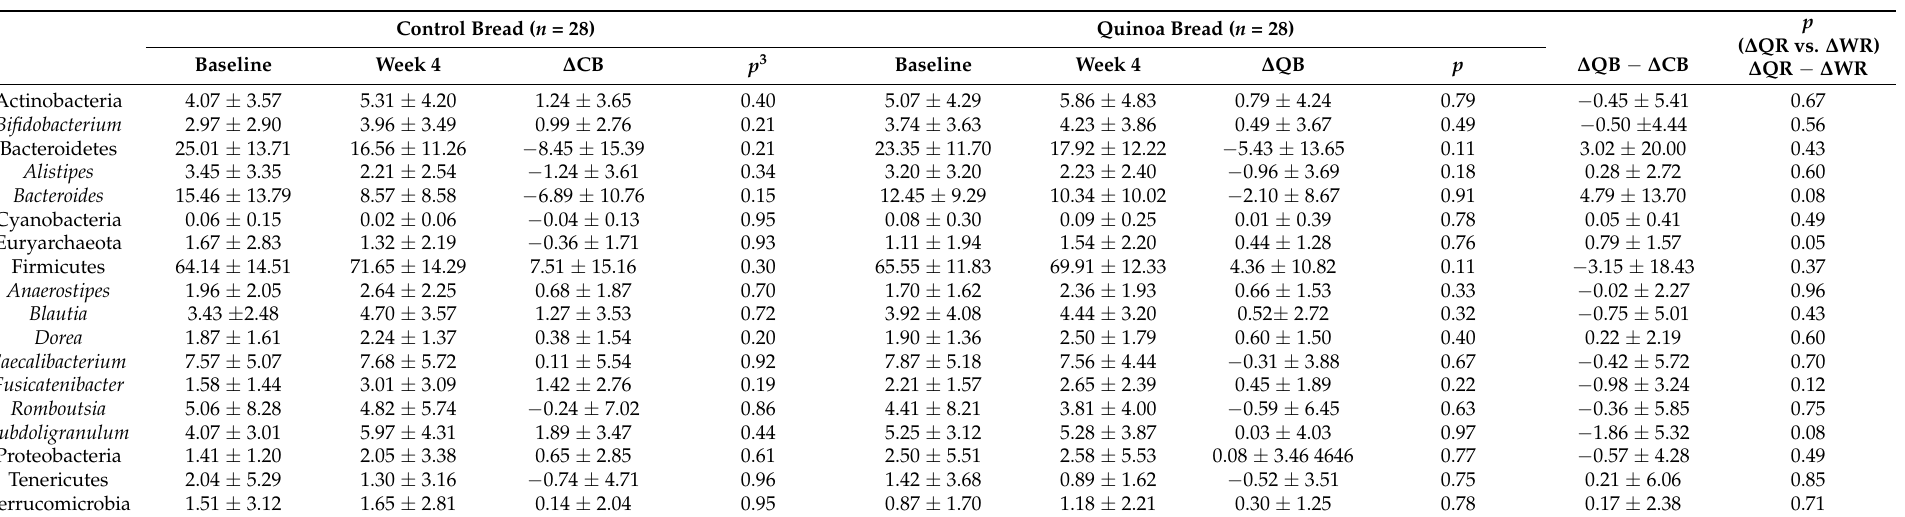
Table 1. Relative abundance of bacterial phylum and genus in stool samples of participants prior to and following 4 weeks consuming a control and quinoa bread roll ( n = 28). Control Bread ( n =